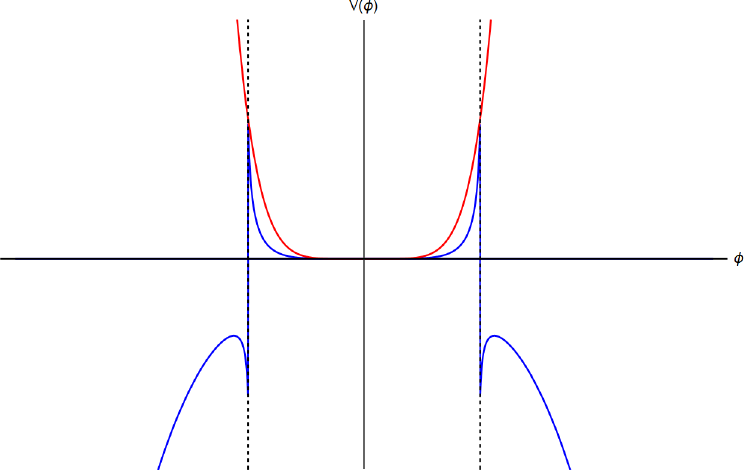
Figure 8 . LL effective potential for the φ 6 (left) theory. The blue line is the LL numerical solution, the red dashed line is the classical